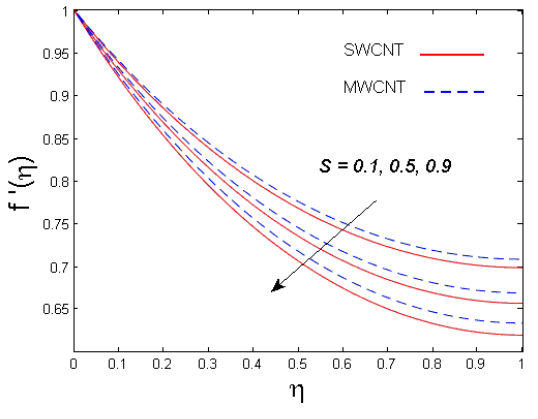
Figure 8. The illustration of S versus f ’(η).